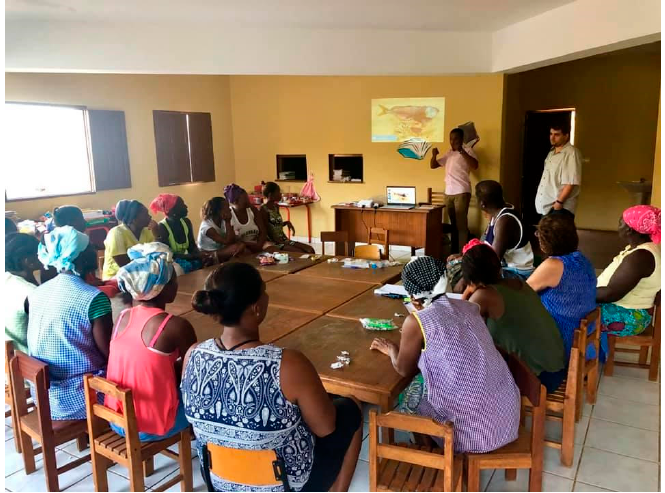
Figure A6. Capacity building regarding marine litter in the participatory session in Porto Gouveia (photos by the authors, September 2019).